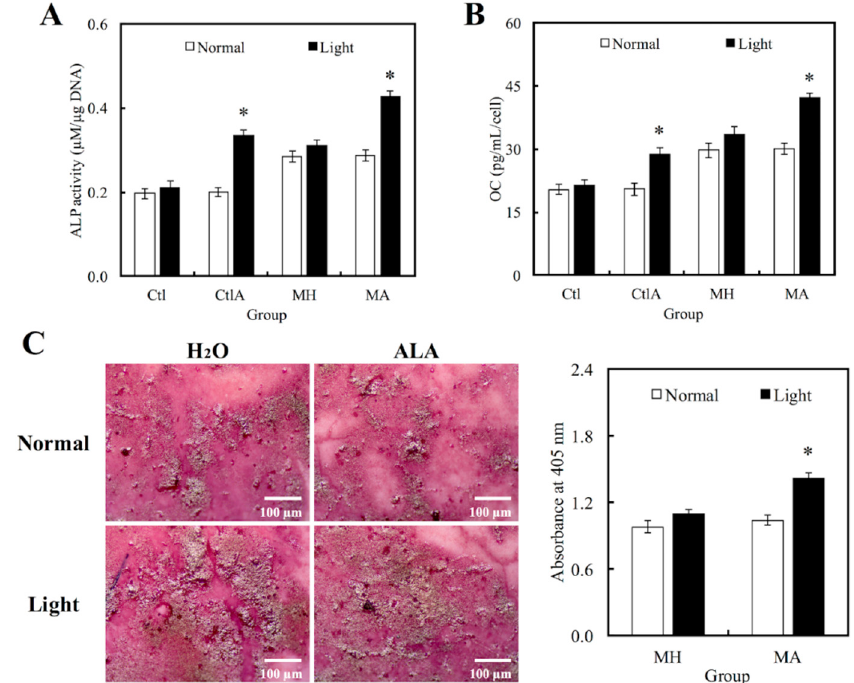
Figure 5. Levels of ( A ) Alkaline phosphatase (ALP) activity and ( B ) Osteocalcin (OC) secretion of hDPCs cultured on MTA-ALA after 7days of culture with red light treatment. ( C ) Images and quantification results of alizarin staining of calcium deposits after two weeks of culture. “*”, significant difference ( p < 0.05) from specimens without red light irradiation.